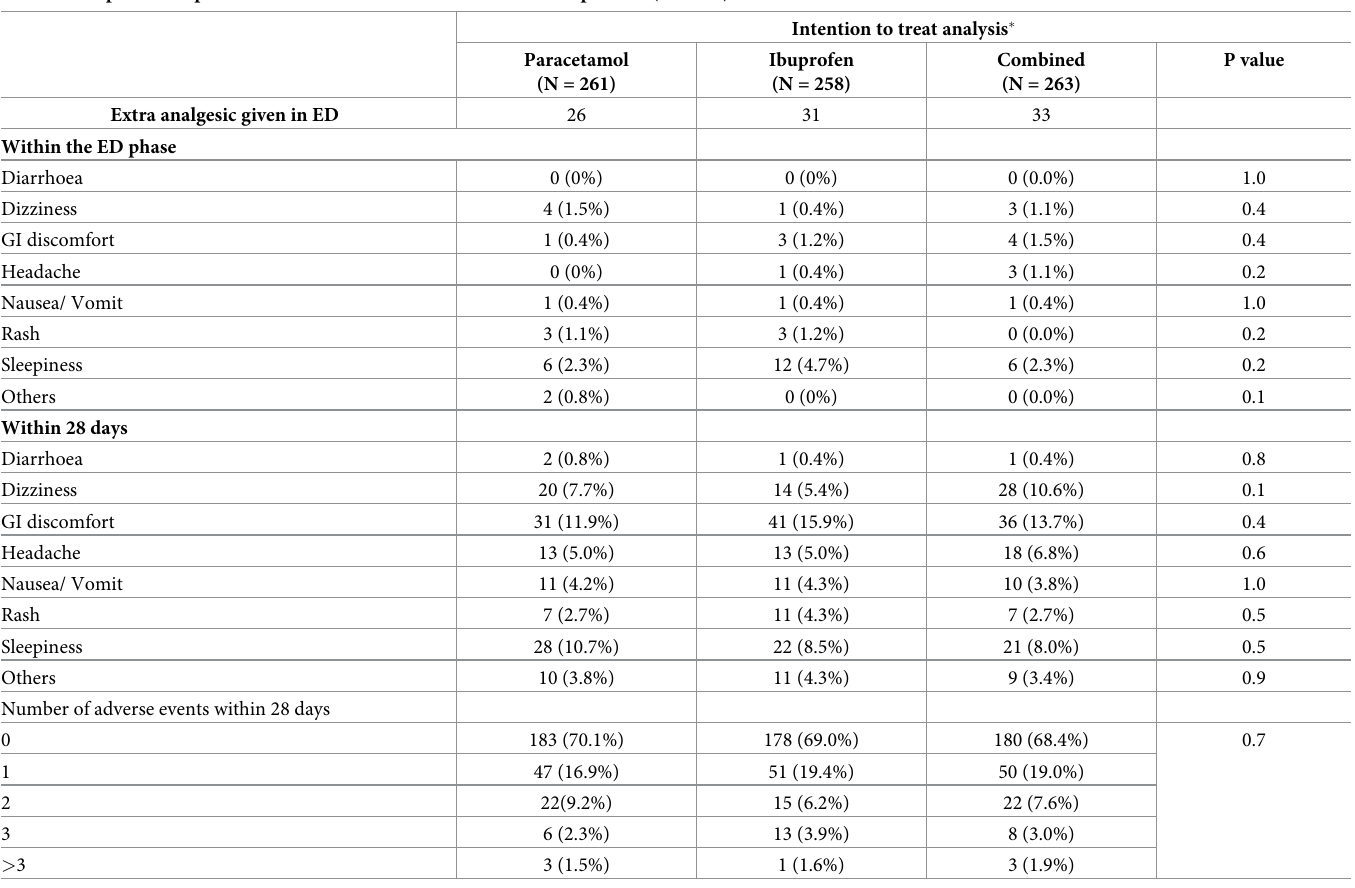
Table 4. Proportion of patients with adverse events in all randomized patients (N =